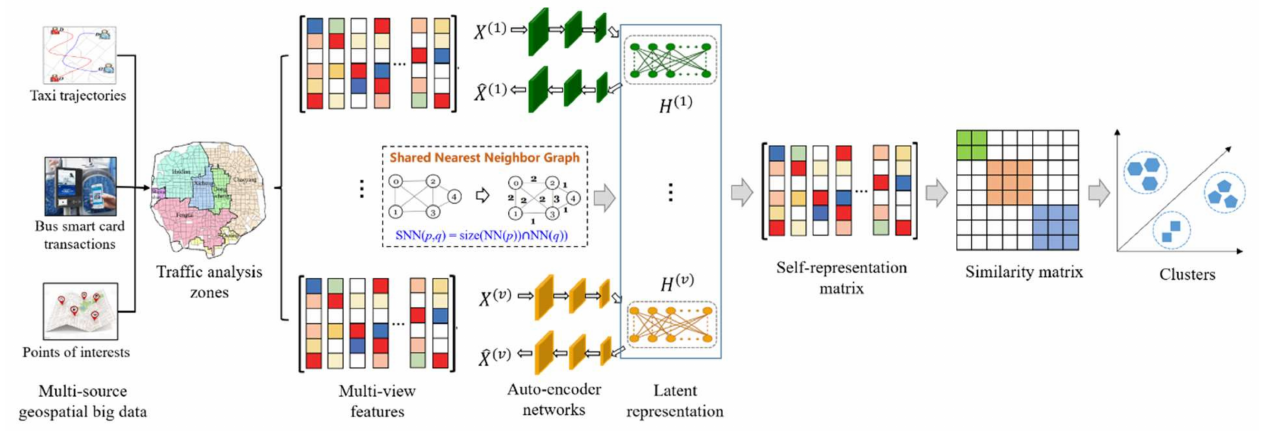
(cid:110) (cid:111) V ˆ X ( v ) ( V ≥ 2) refer to the reconstructed multi-view features; v = 1